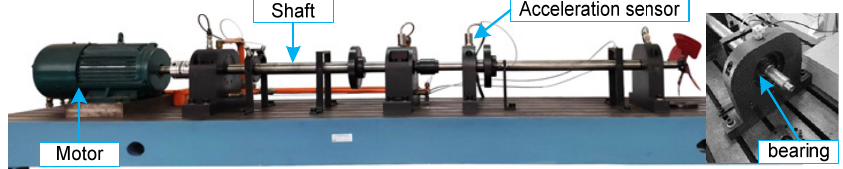
Figure 9. Accelerated bearing life tester.